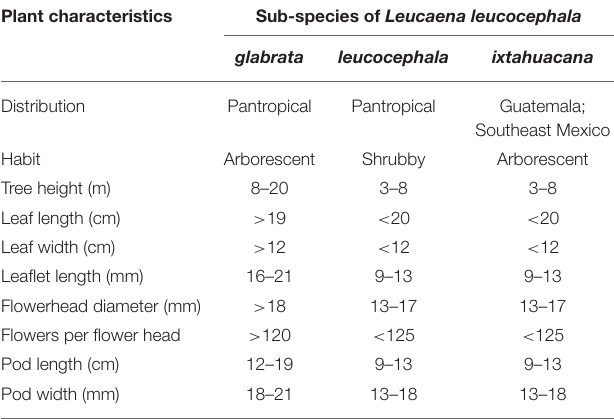
TABLE 1 | General characteristics of the three subspecies of Leucaena leucocephala